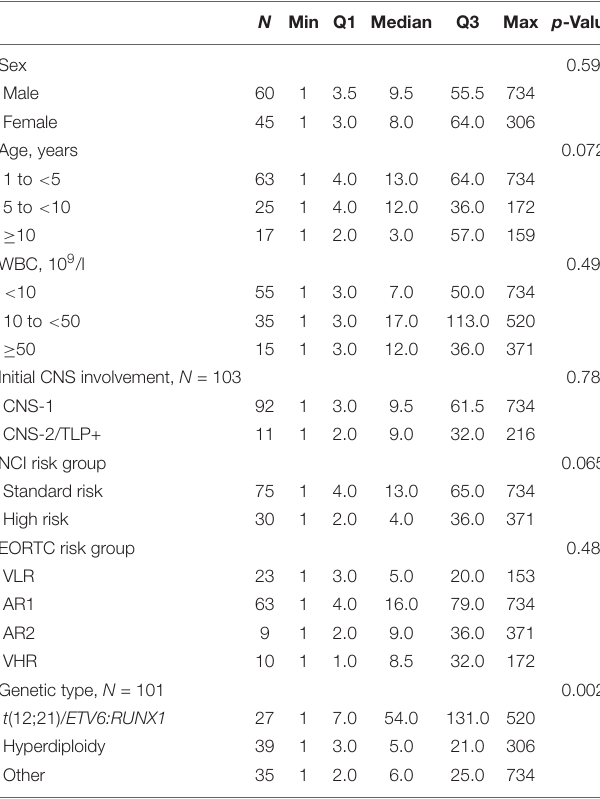
TABLE 4 | Associations between the maximum number of evolved clones and patients’